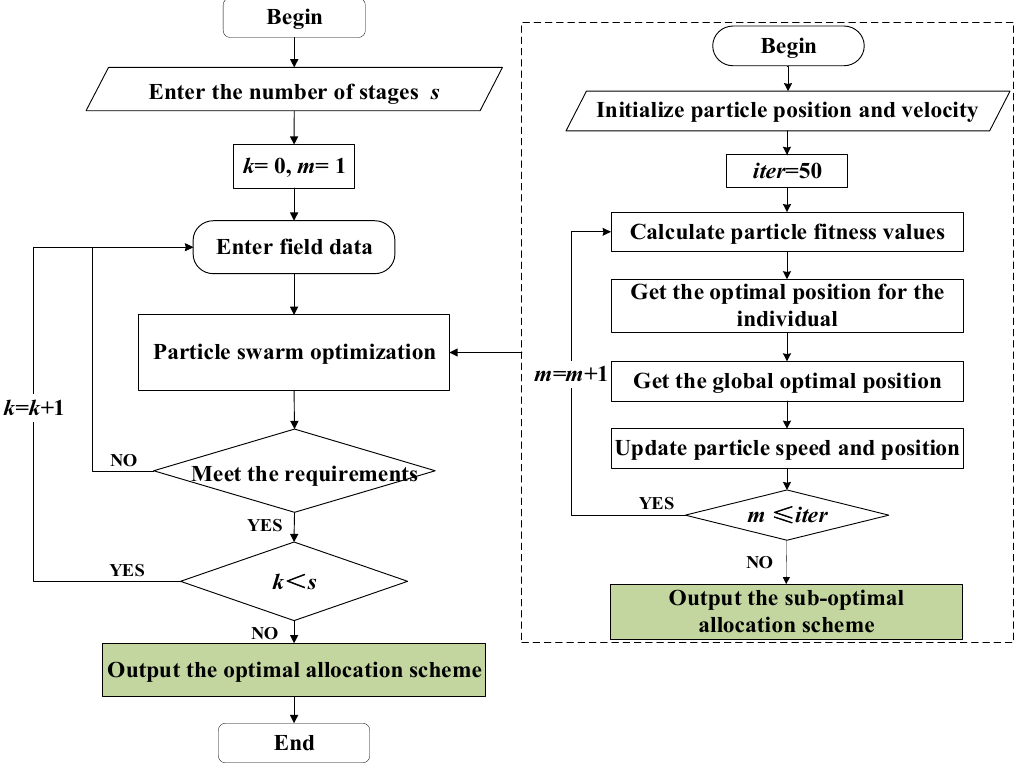
Figure 5. The solving flow of ballast water allocation scheme based on PSO.